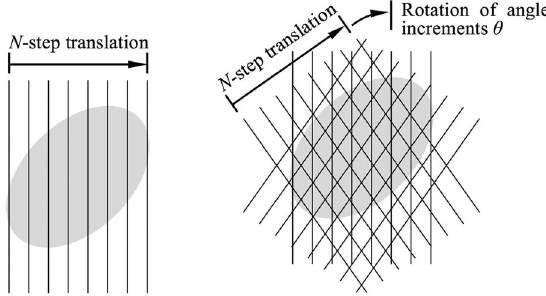
FIG. 1. One-dimensional (left) and two-dimensional (right) trans- verse profile measurement by scanning the wire through the beam.